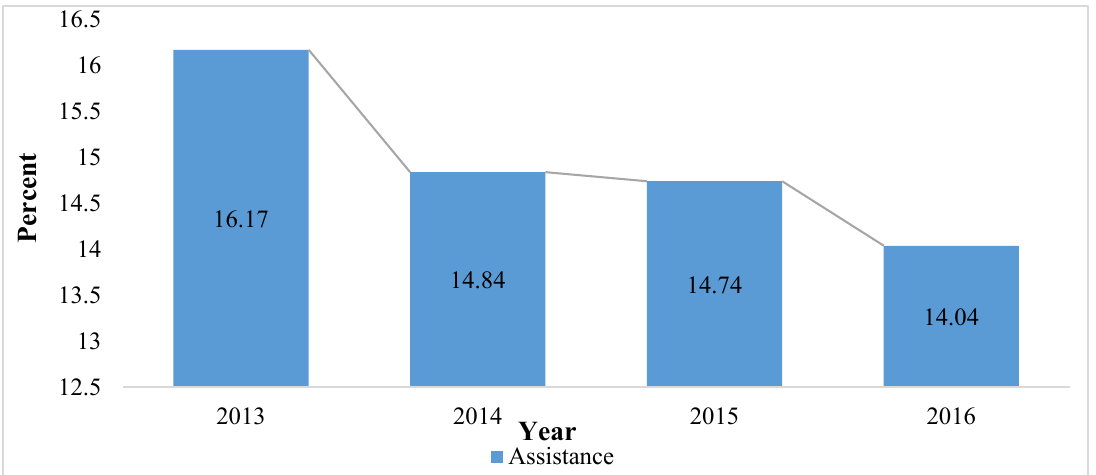
Figure 1. Number of farmers who received assistance from 2013 to 2016.